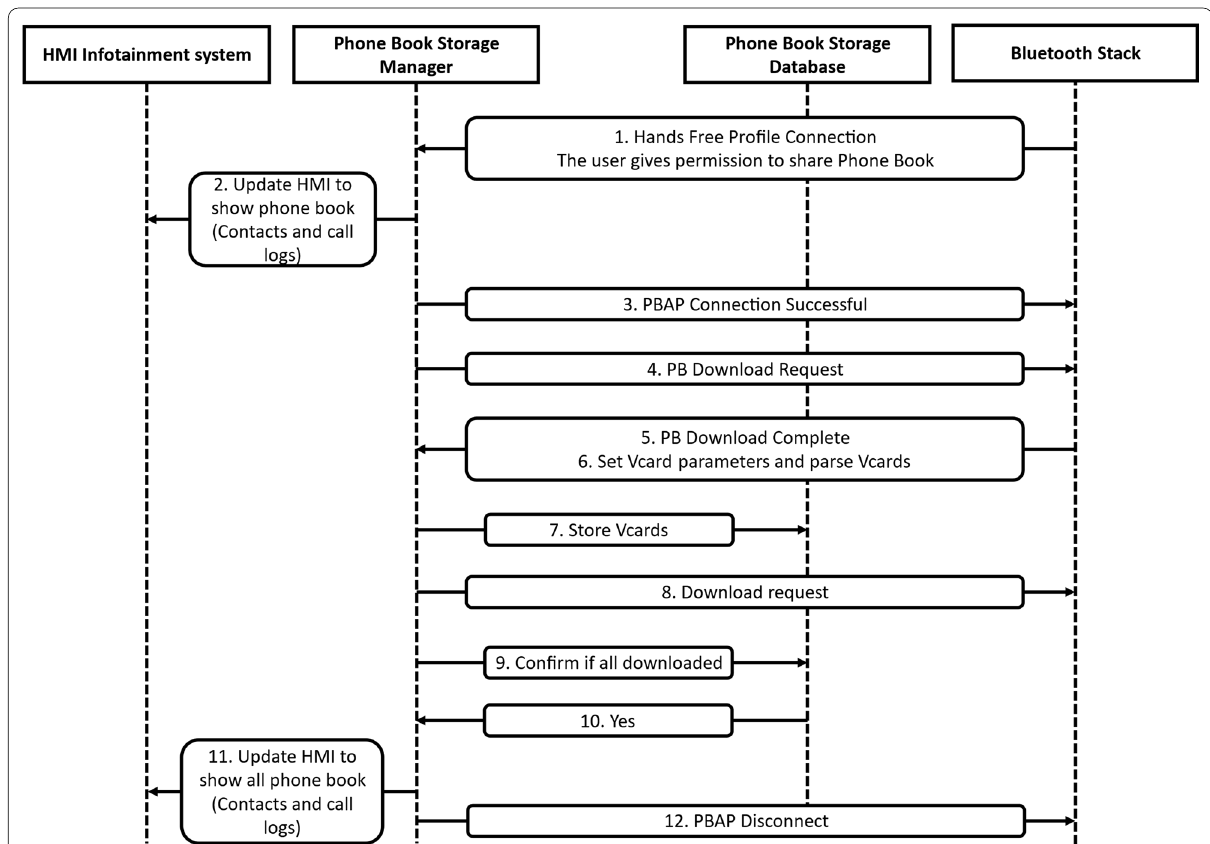
Fig. 4 Pone book access profile download process between the infotainment system and the Bluetooth device